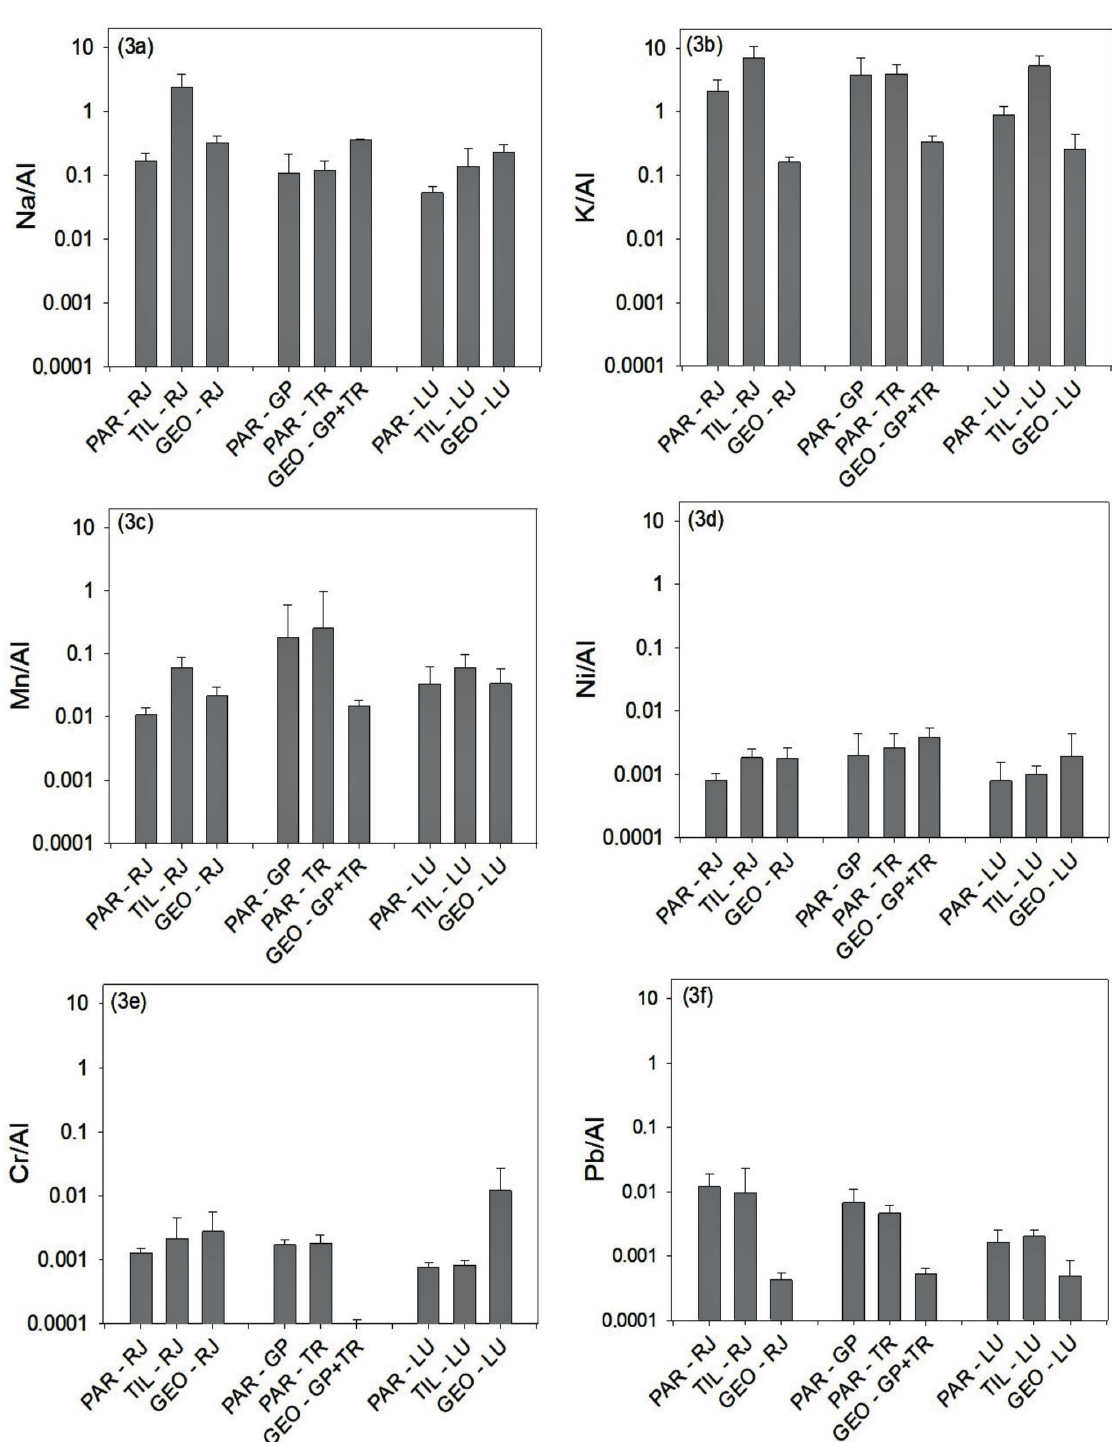
Figure 3 - Histogram of metallic elements (Na, K, Mn, Cr, Ni and Pb) normalized by Al for Parmotrema crinitum (Ach.), Tillandsia usneoides (L.) and rocks from sampling area in Rio de Janeiro